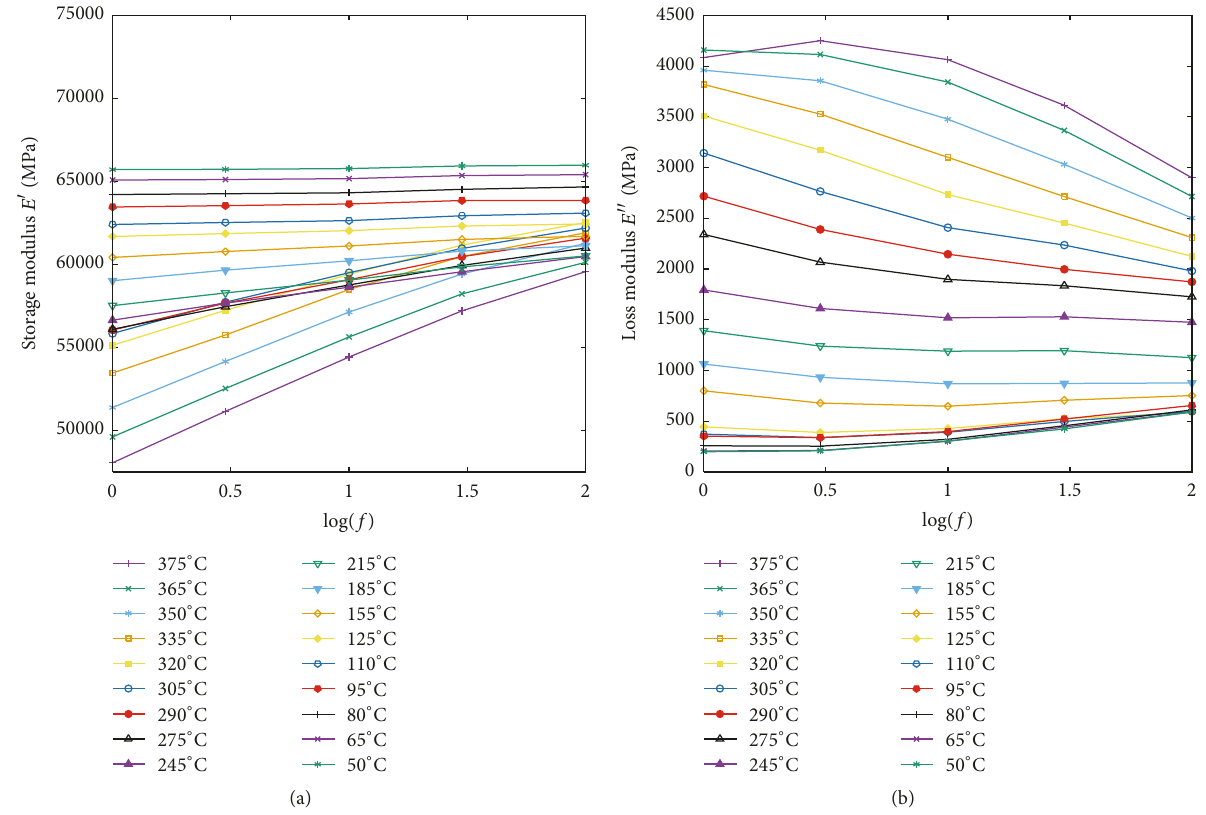
Figure 1: Isothermal storage modulus 𝐸 󸀠 (a) and loss modulus 𝐸 󸀠󸀠 (b) versus logarithm of the frequency 𝑓 from DMA tests on AA 7075-T6 at frequencies ranging from 1 to 100Hz and from 50 to 375 ∘